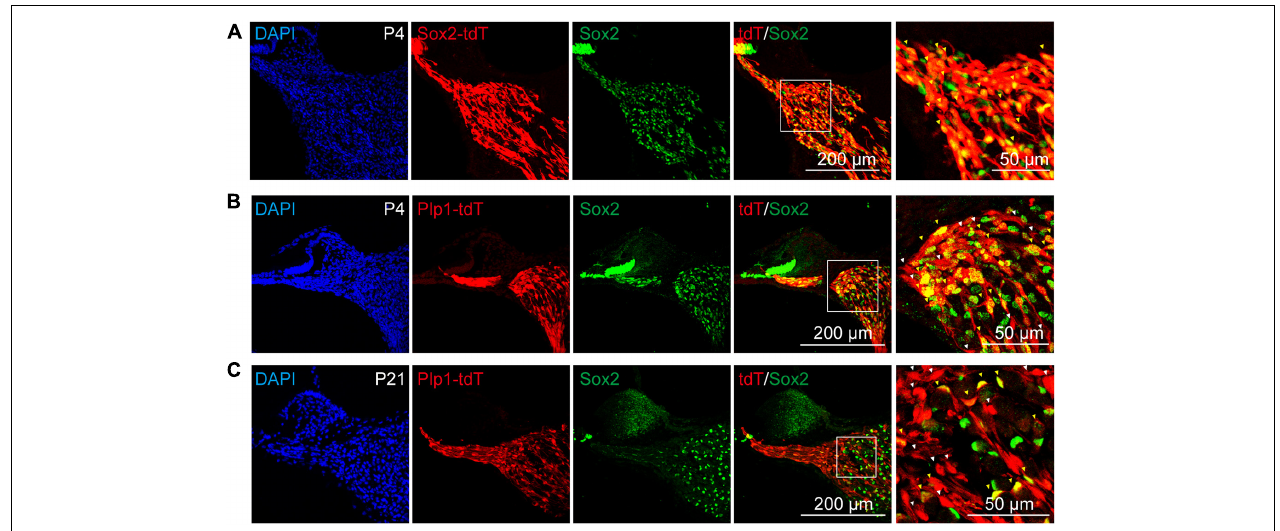
FIGURE 2 | Sox2 labels a subpopulation of cochlear glial cells. (A) Immunocytochemical staining of Sox2-tdT cochlea for Sox2, showed Sox2-Cre:tdTomato labeled the Sox2 positive cochlear glial cells in P4 mice. The yellow arrowheads represent Sox2-tdT + /Sox2 + cells. (B,C) Sox2 were expressed in a subpopulation of Plp1-tdT positive cells in both P4 (B) and P21 (C) cochlea. The white arrowheads represent Plp1-tdT + /Sox2 − cells, and the yellow arrows represent Plp1-tdT + /Sox2 + cells. tdTomato expression was induced by tamoxifen from P1 to